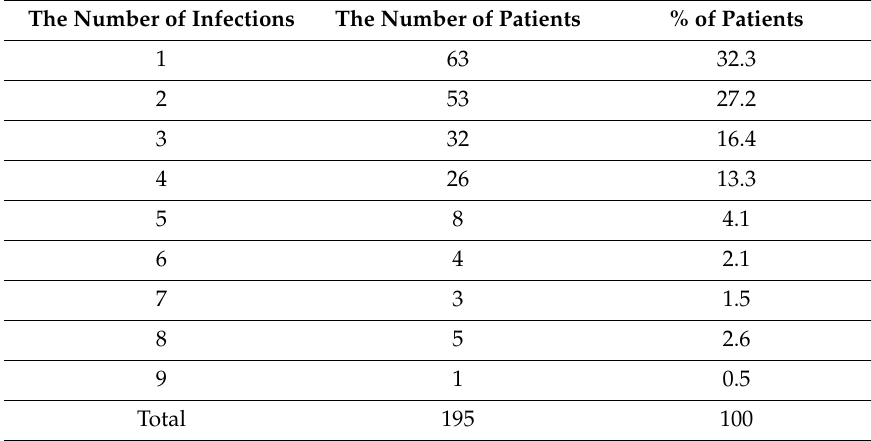
Table 4. Distribution of patients according to the number of infections. The Number of